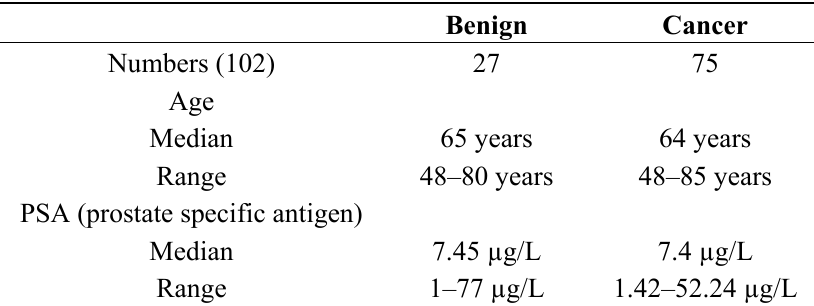
Table 2. Patient demographics.